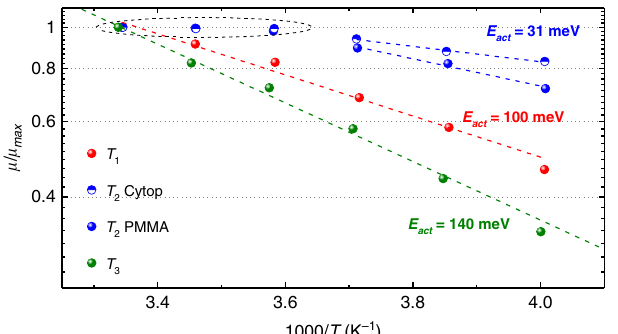
Fig. 7 Mobility as a function of temperature. Comparison of µ para / µ max vs. 1/ T from the FETs of this work in the direction parallel to